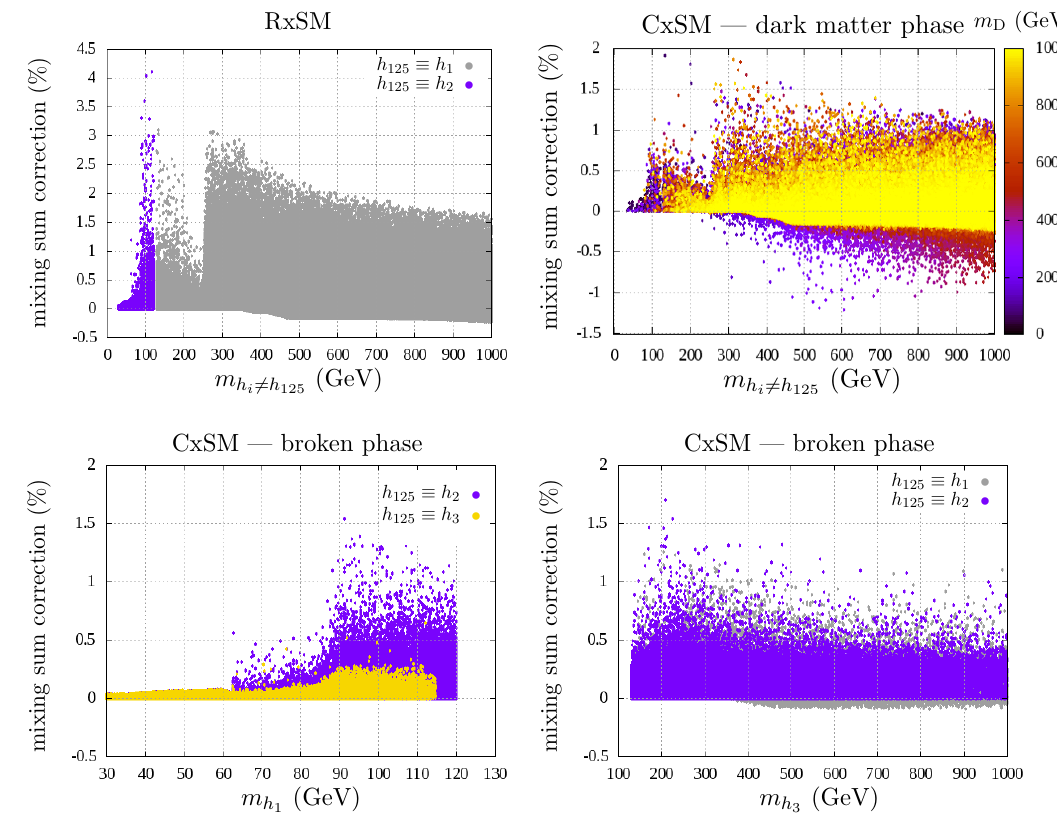
Figure 2 . Mixing sum corrections : in all panels we present the one-loop mixing sum correction (vertical axis), versus the mass of one of the new non-SM like Higgs bosons (horizontal axis), for three models. Top left , the RxSM; top right , the CxSM dark phase with the non-SM like Higgs boson mass in the horizontal axis and the dark matter mass in the colour scale; bottom , the CxSM broken phase with either the lighter (left) or the heavier (right) of the non-SM like Higgs masses in the horizontal